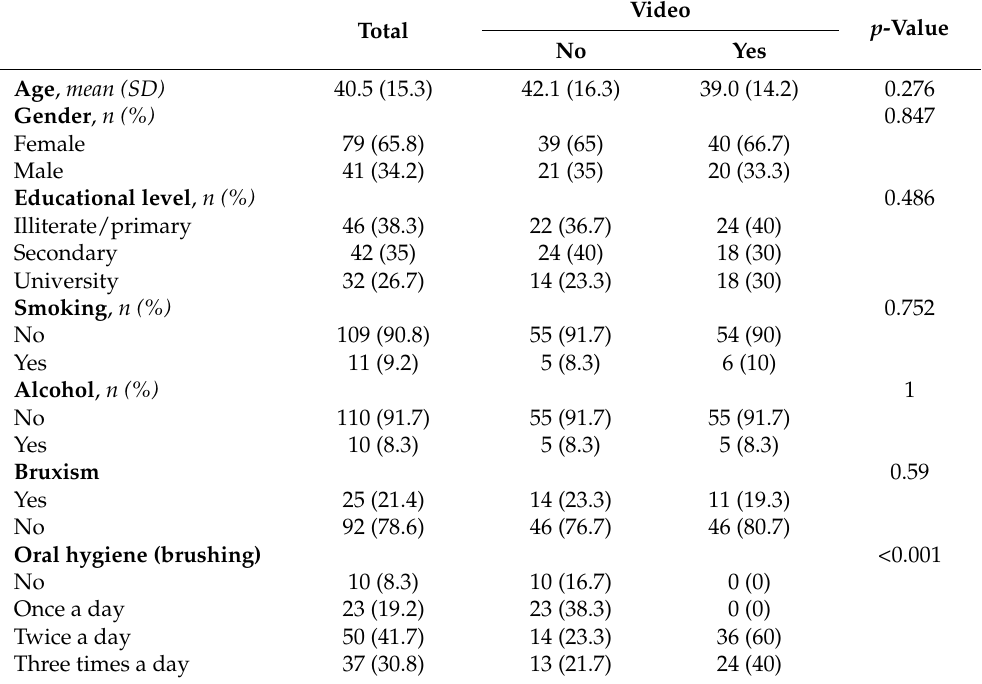
Table 1. Description and comparison of the demographic data and habits of the study subjects. Total